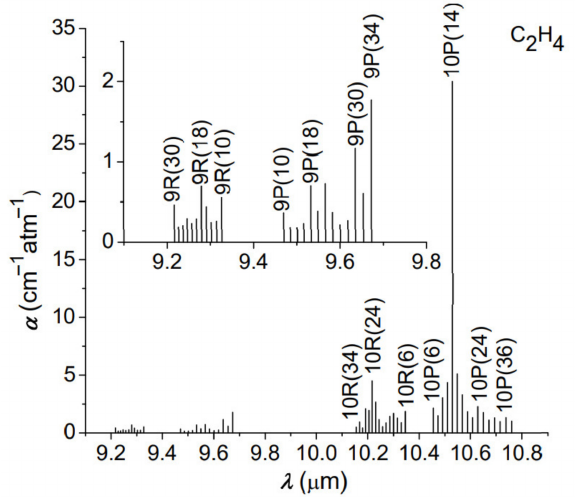
Figure 3. C 2 H 4 absorption coefficients for all laser